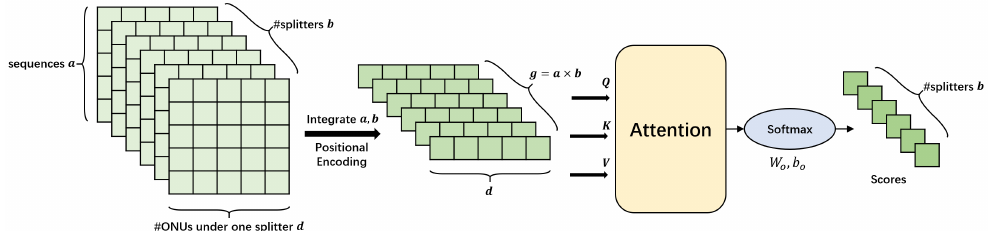
Figure 8. Principle of TransVoter. All scores of sequence pairs concerning one ONU are aggregated and processed to predict its